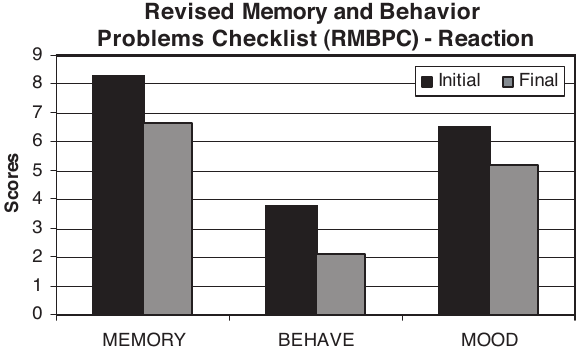
Figure 2. Shows scores for caregiver reaction in relation to patient’s memory, behavior, and mood symptoms on the RMBPC. We noted a significant difference in memory, behavioral and mood scores between the first and second caregiver evaluation (Z= –1. 299, p=0.194), (Z= –1.309, p=0.191) and (Z=0.49, p=0.624). Scores for caregiver reac- tions in relation to patient’s memory, behavior, and mood